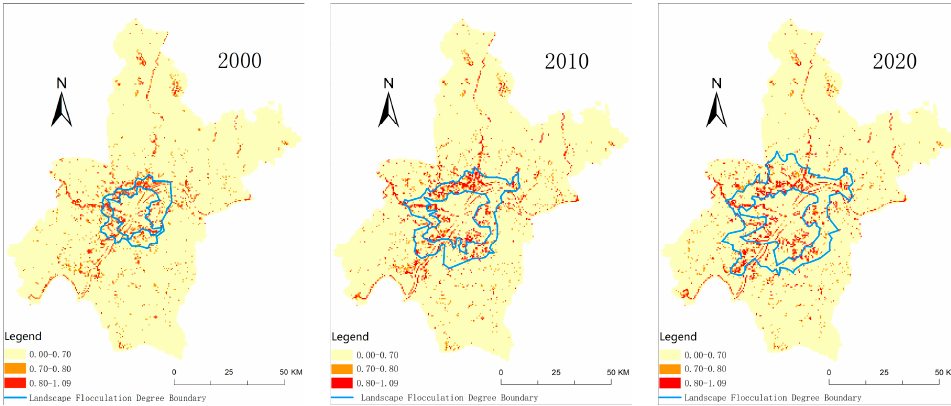
Figure 6. The spatial division of landscape flocculation in the urban fringe of Wuhan,